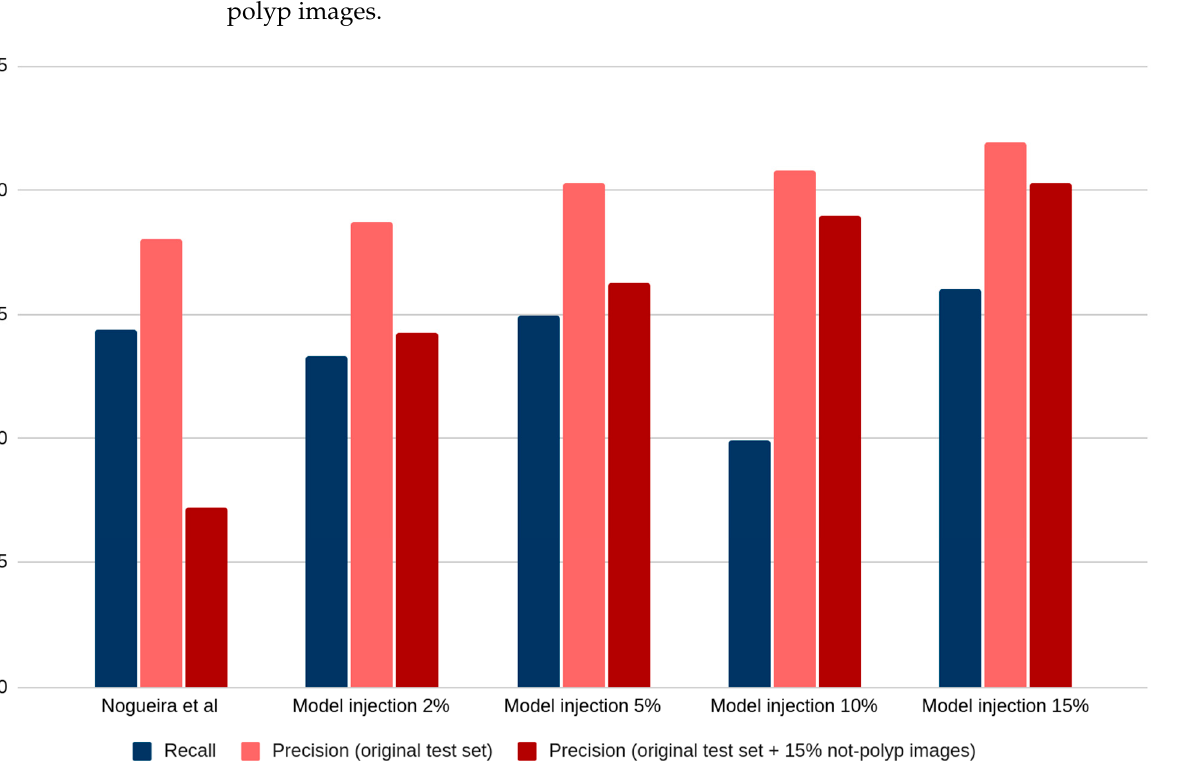
Figure 3. Recall of the five trained models (blue) and their precision in both the original test partition (pink) and the same with the addition of 15% of not-polyp images (dark red) [11]. It can be observed from Figure 3 that the precision decay of the original model is the biggest one (red bars in the leftmost column of Figure 3). However, as we create models trained with an increasing number of not-polyp images, this precision recovers (dark red bars’ progression in Figure